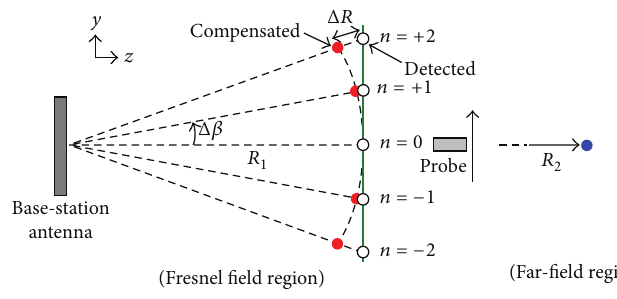
Figure 1: Scheme of the proposed method.